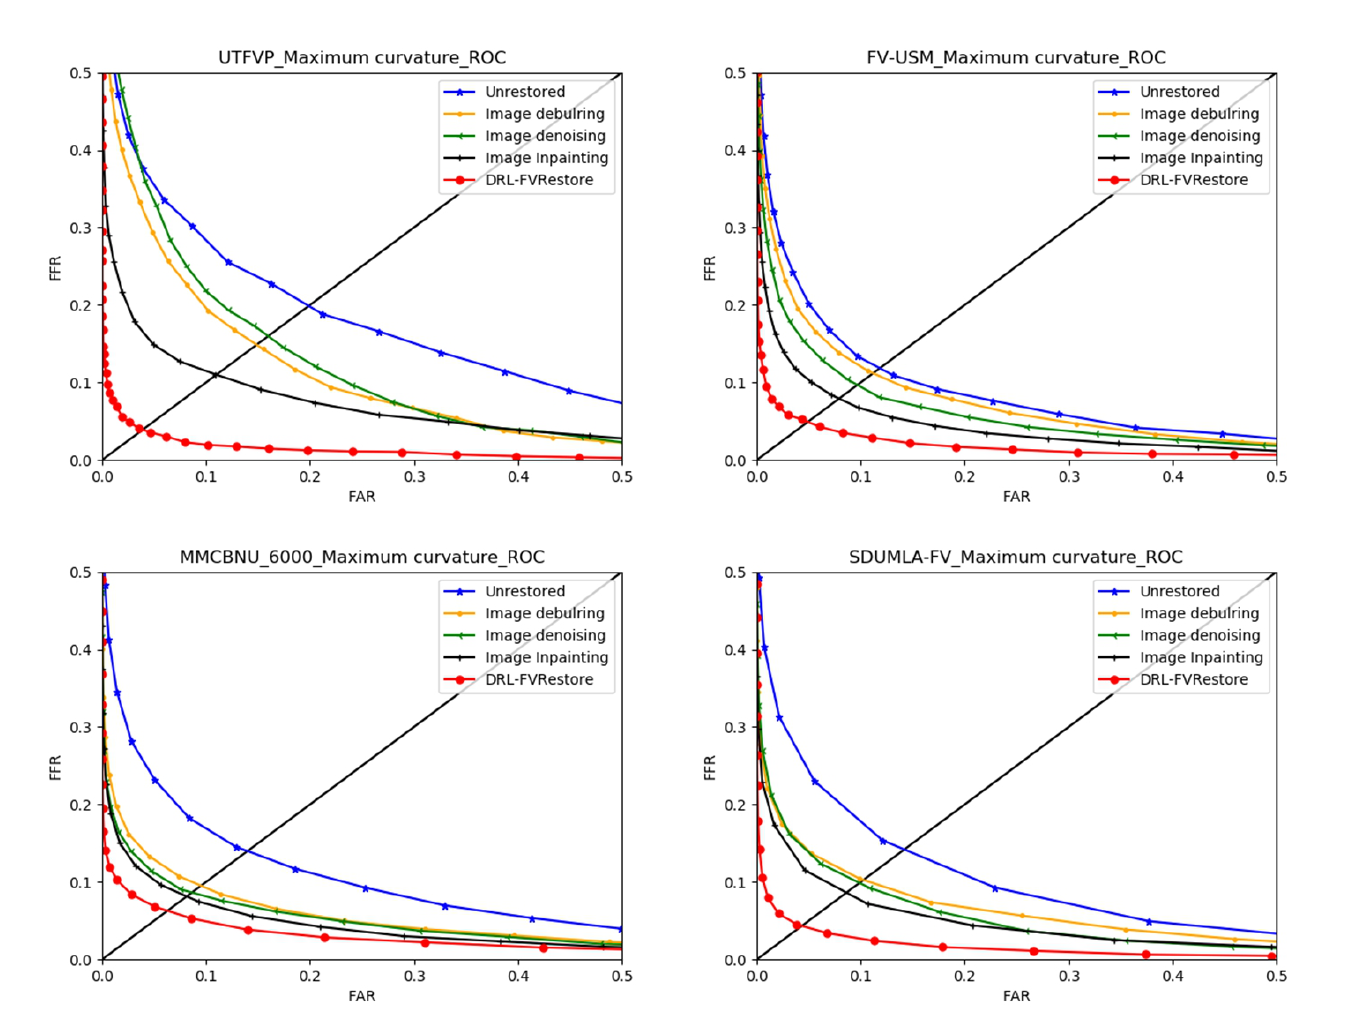
Figure 14. The ROC curves of various image restored methods on the different public